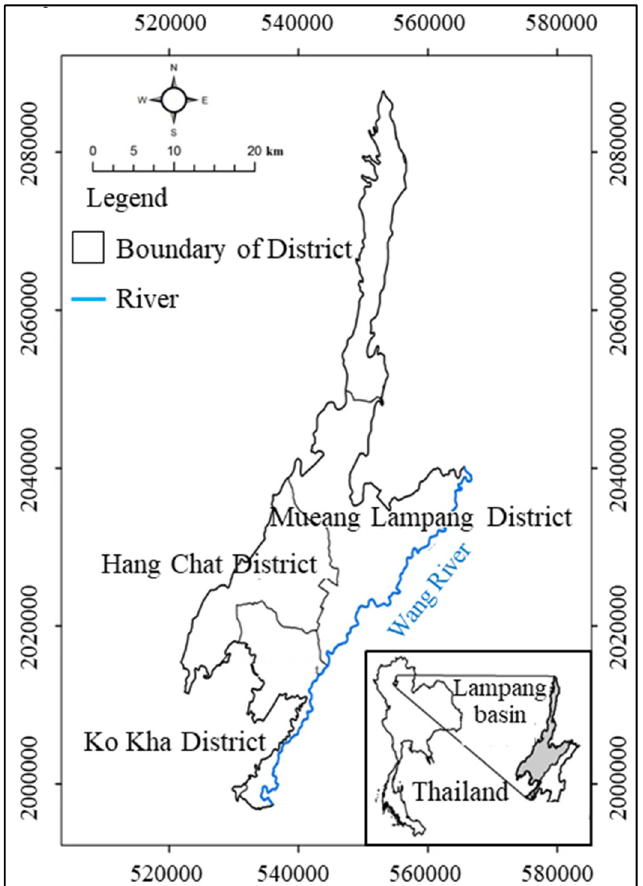
Figure 1. Western part of the Lampang Basin, Lampang province, Northern Thailand with Wang river flowing from north to south.